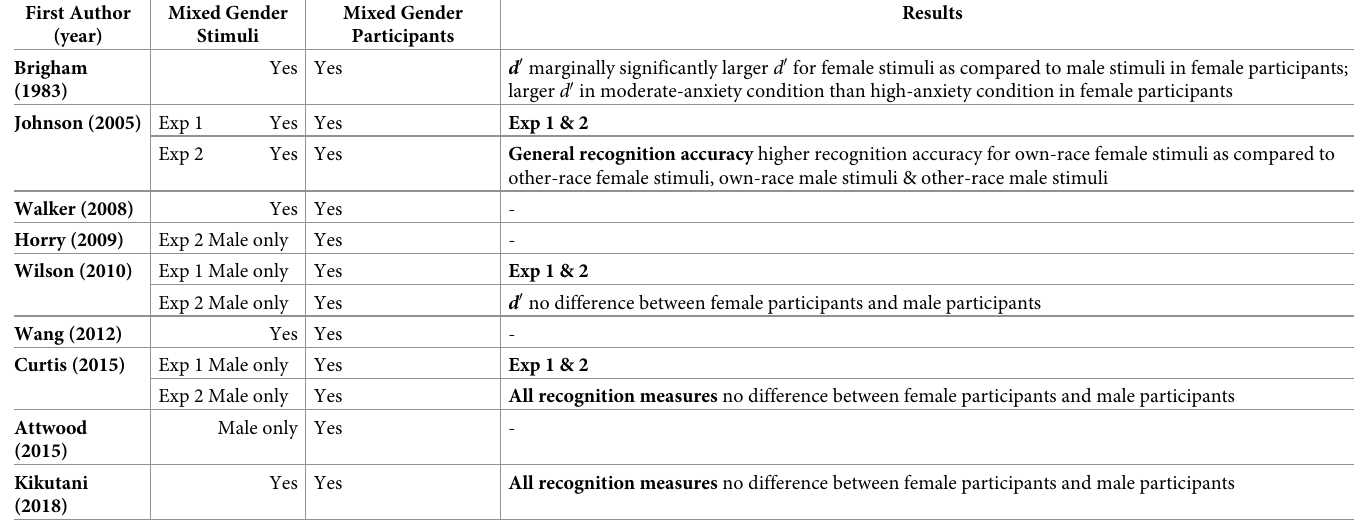
Table 2. Gender of participant and stimuli for included studies, with associated results, including interaction with other